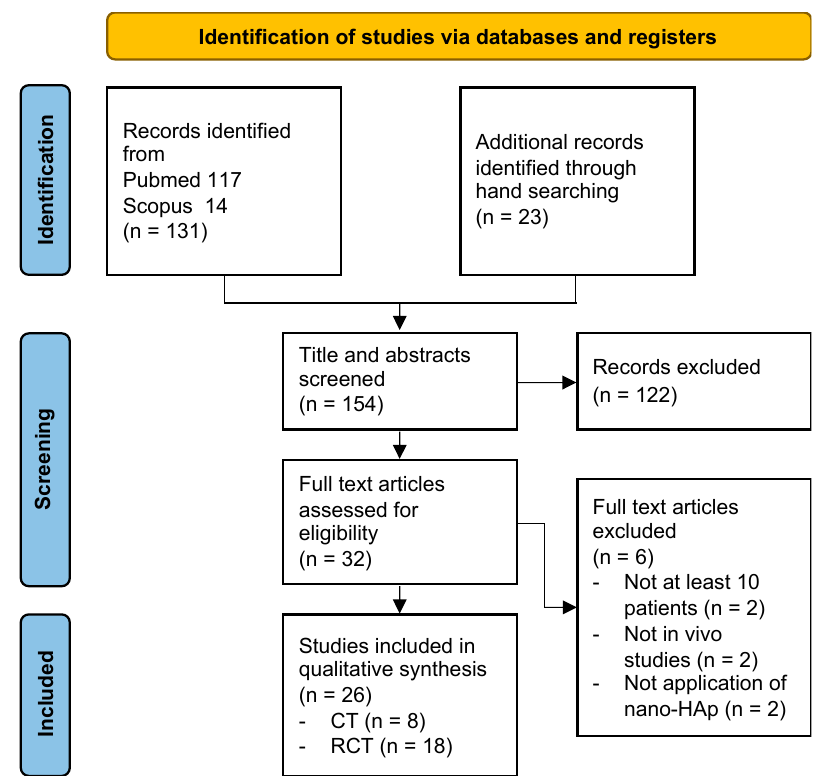
Figure 1. Flowchart of the literature search according to PRISMA guidelines.